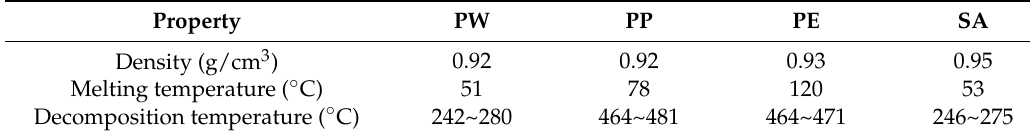
Table 2. Binder compositions and related